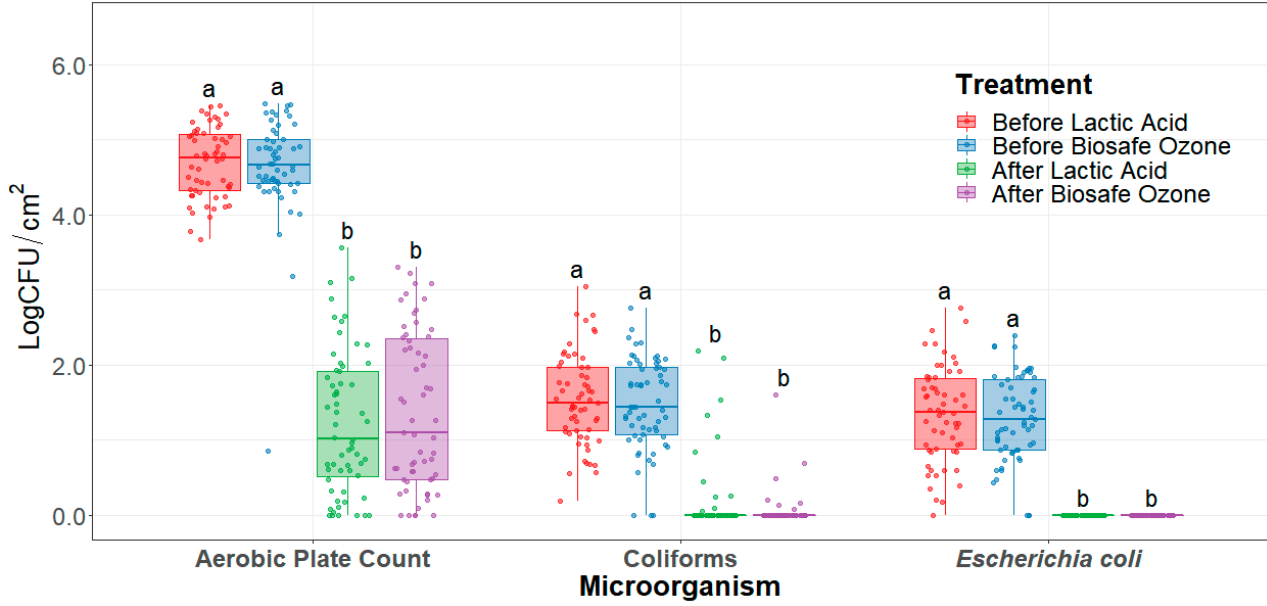
Figure 1. Carcass Aerobic plate count, coliform, and Escherichia coli counts (limit of detection < 0.05 CFU/cm 2 ) before and after the application of the interventions (LogCFU/cm 2 ). Horizontal line within the boxplot represents the median. The box upper and lower limit represents the interquartile range, and the bars represent 1.5xInterquartile Range. a,b Box plots with different letters within the same microorganism type represent statistical differences ( p < 0.05).